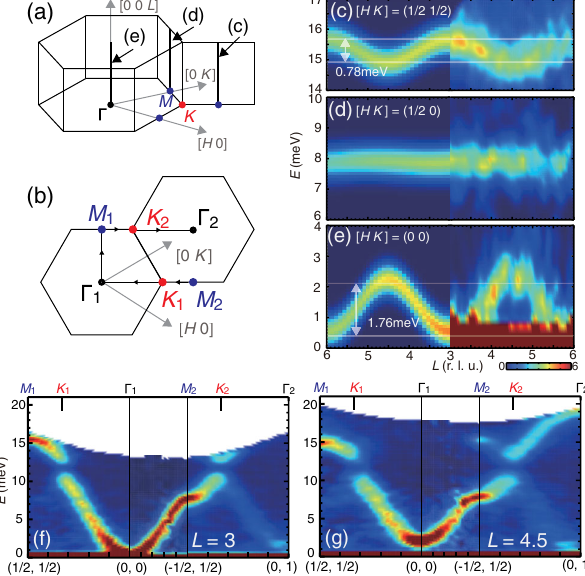
FIG. 2. Spin wave spectra of CrI 3 . (a) The hexagonal reciprocal lattice of CrI 3 . Gray arrows show reciprocal lattice vectors, and high-symmetry ( Γ ; K; M ) points are specified in blue ( M ), red ( K ), and black ( Γ ) dots, respectively. The bold black lines specify the scan direction in (c – e). (b) Projection of the hexagonal reciprocal lattice in the ½ H; K (cid:3) plane. The arrows indicate the scan path of the spectra shown in (f, g), Figs. 3(a) – 3(c), and Figs. 4(a) and 4(b). (c – e) The spin wave dispersion along the L direction at different ½ H; K (cid:3) positions specified in (a), showing different bandwidths at different ½ H; K (cid:3) points. The left and right panels are calculation and data, respectively. (f, g) Spin wave dispersion at different L points. (f) shows L integration range ½ 2 . 5 ; 3 . 5 (cid:3) near the ½ 0 ; 0 ; L (cid:3) band bottom, while (g) shows L integration range ½ 4 ; 5 (cid:3) near the band top. sample in the horizontal scattering plane and with the applied magnetic fields vertical, i.e., in the ab plane of CrI 3 [Figs. 1(a), (c), and (d)].